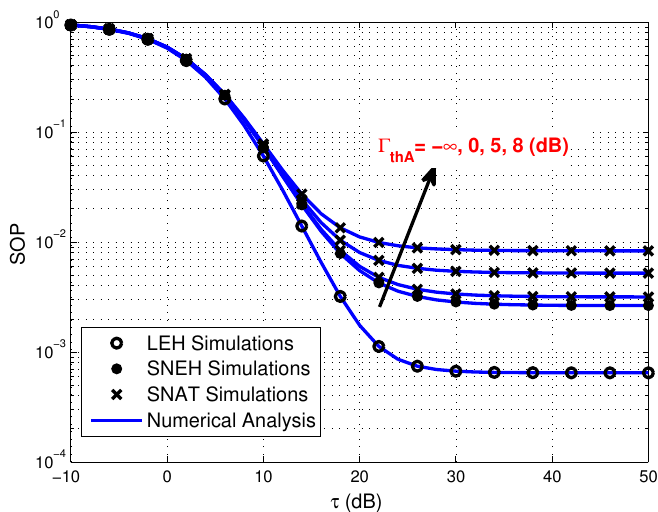
Figure 7. Secrecy outage probability versus τ for three EH modes under various Γ th _ A , where Γ th _ S = 10 dB and Γ th _ A = {− ∞ ,0,5,8 } .